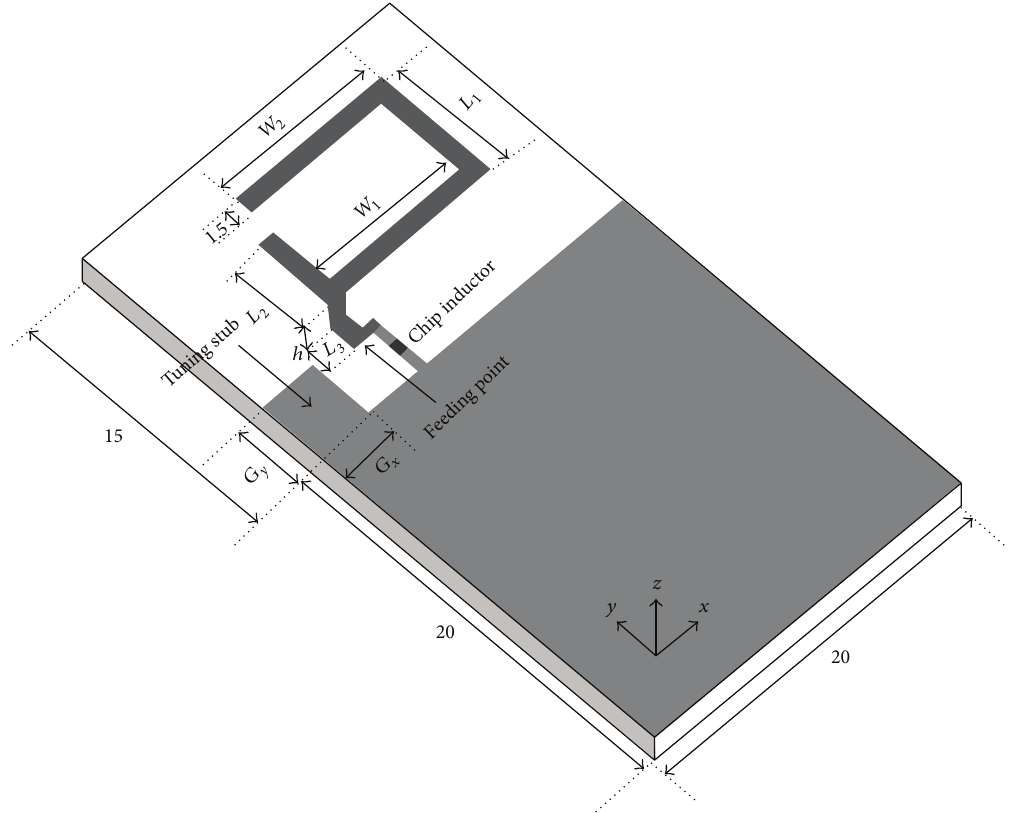
Figure 1: Geometry of the proposed WLAN